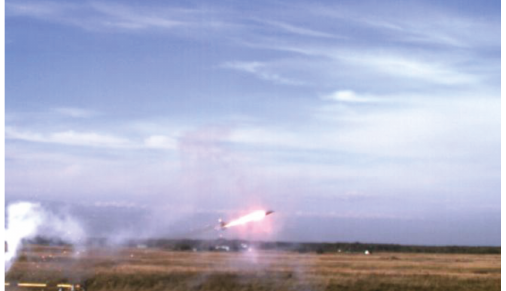
Figure 3: ICP-89 aerial target imitator approximately 20 msec after being